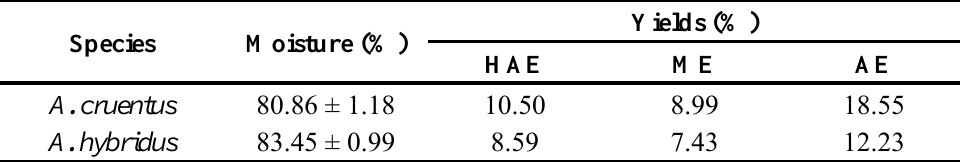
Table 1. Moisture and extract yields (from dry plant materials) of studied vegetables.